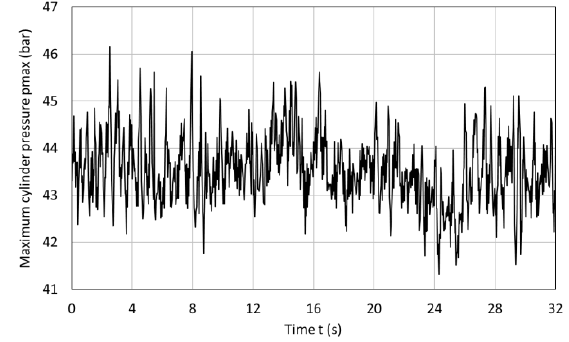
Fig. 9. Maximum cylinder pressure for operating point No. 2 The increase in the load resulted in the reduction of pressure instability in the cylinder. Its value for the 2nd operating point varied from 41.32 to 46.16 bar. The average value of p for this case was less than the value corre- max sponding to the 1st operating point.